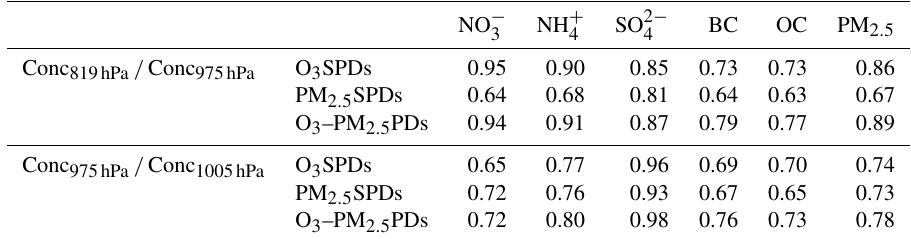
Figure 8. The vertical distributions of (a) concentrations of O 3 (ppb) and (b) PM 2 . 5 components (µgm − 3 ) of NO averaged over the model-captured O 3 SPDs, PM 2 . 5 SPDs, and O 3 –PM 2 . 5 PDs in BTH in the months of April to October of 2013–2020. Table 1. The ratios at 975 and 1005hPa (shaded gray area in Fig. 8) and at 819 and 975hPa (red frame in Fig. 8) of NO OC, and PM 2 . 5 on O 3 SPDs, PM 2 . 5 SPDs, and O 3 –PM 2 . 5 PDs in BTH